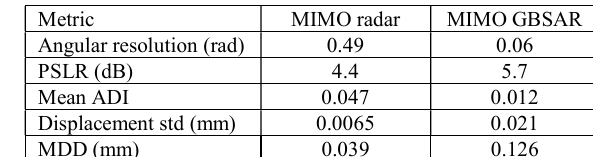
radar measurements are closer to the reference values and, thus, are more accurate.